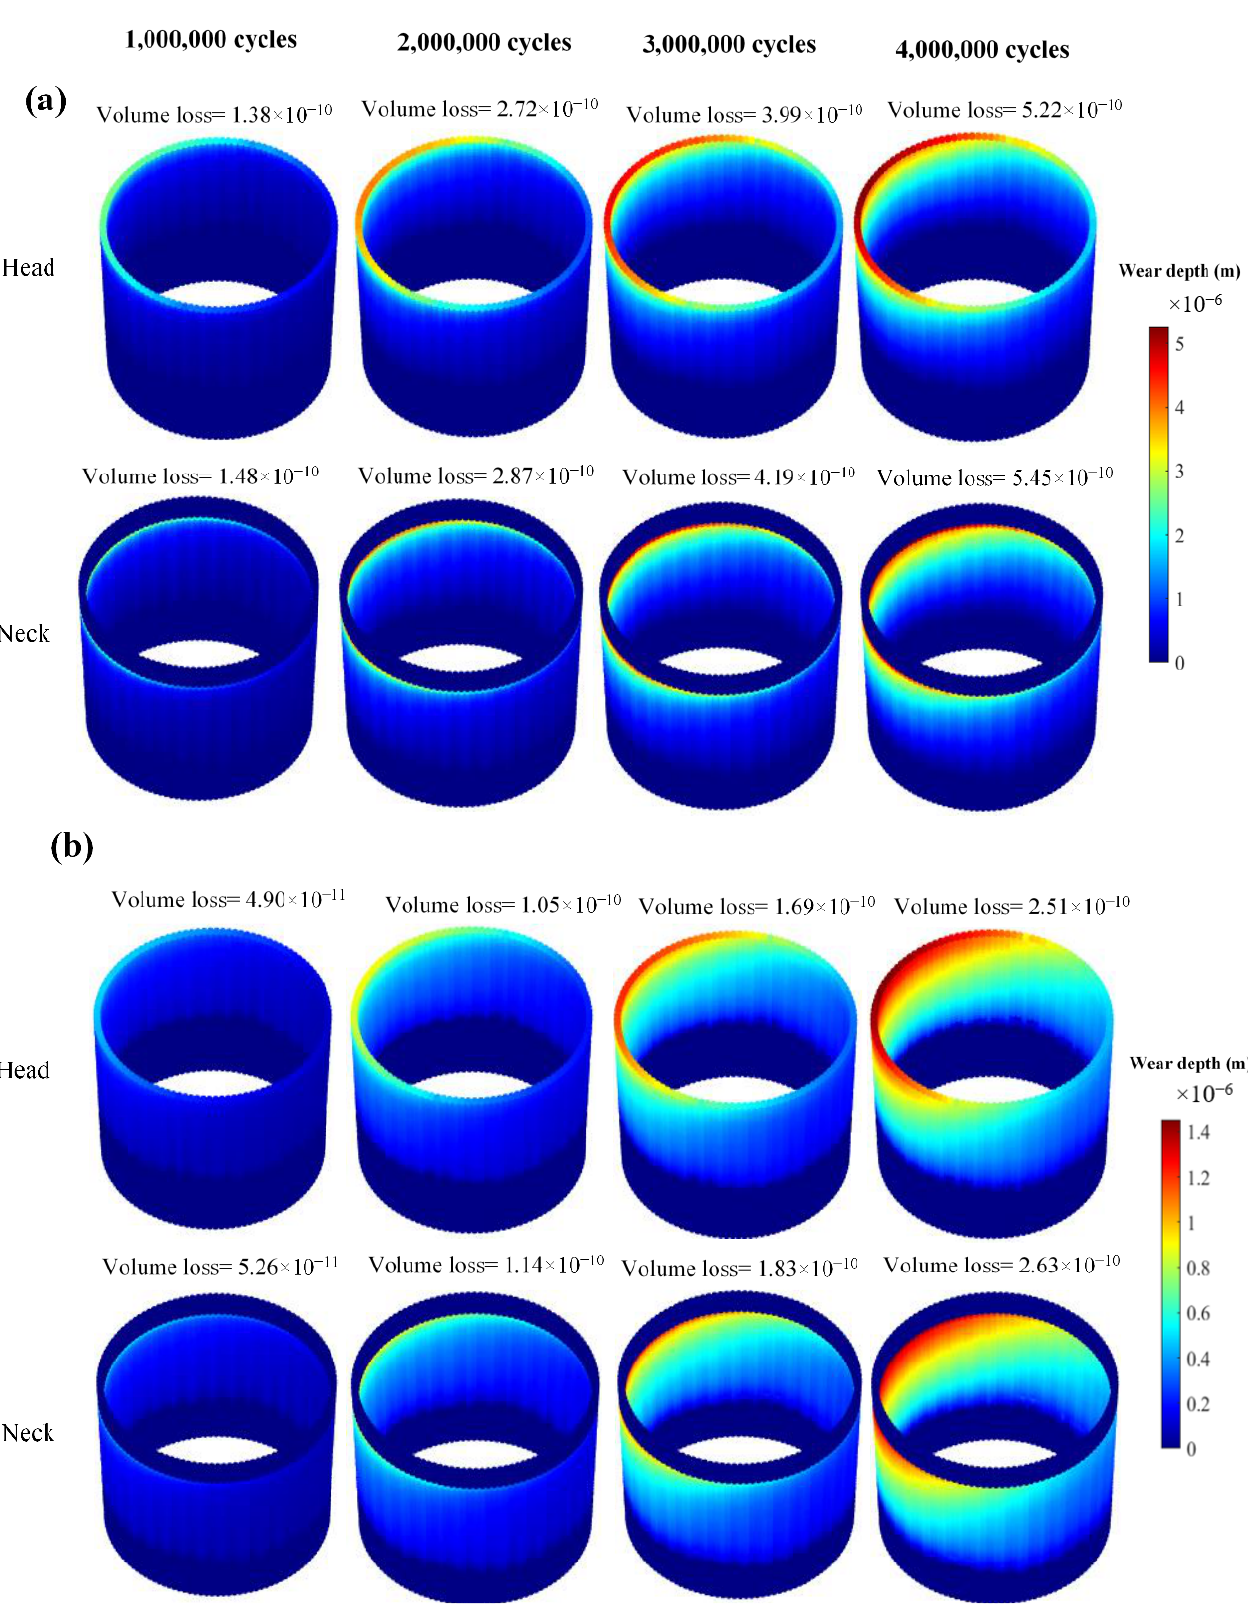
Figure 3. Wear profiles of the head and neck contact surfaces: ( a ) Mechanical; ( b ) Chemical (the wear results are presented in meter).